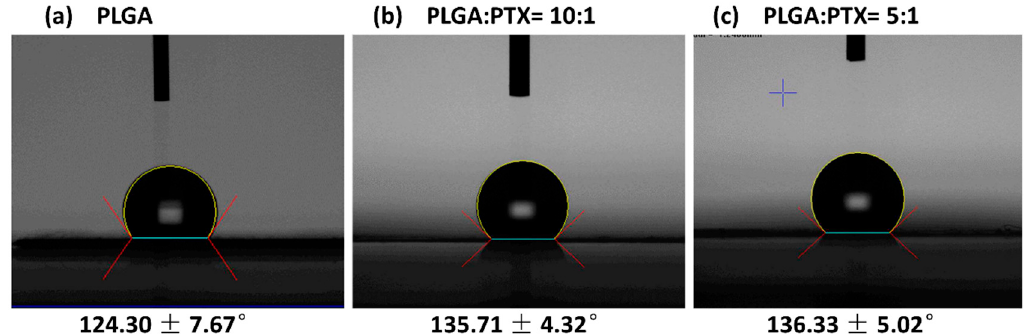
Figure 3. Water contact angles ( a ) 124.30 ± 7.67°, ( b ) 135.71 ± 4.32°, and ( c ) 136.33 ± 5.02°. The drug-eluting membranes showed greater water contact angles compared with the blank PLGA membrane, indicating hydrophilicity reduction after the addition of hydrophobic PTX into the PLGA.